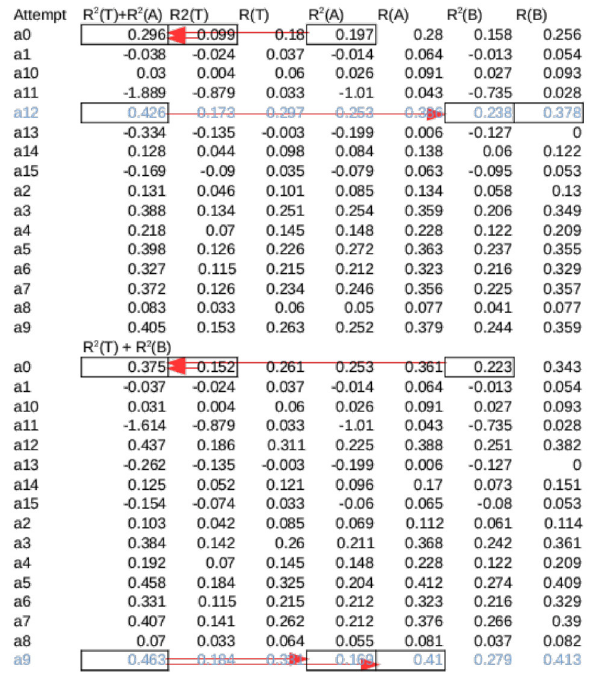
FIGURE 5 | Cross validation for a session from Rat 15—The same session in Figure 7 , marked with black arrow in Figure 6B . Training was attempted 16 times from different initial conditions (a0–a15). Each attempt produced 2 Models, A max and B max , which had the maximum overall R 2 across all sessions for set A and B, respectively. The sum of R 2 of each A max for set A and Test were summed (marked by arrows on a0), and the model with the highest sum was tested on B (marked by arrows on a13). Likewise, the model among B max with the highest sum of R 2 for set B and Test was tested on A. The average of these two values were the overall performance for the session. Note that this is not necessarily the highest possible R 2 , as seen in the first half of the